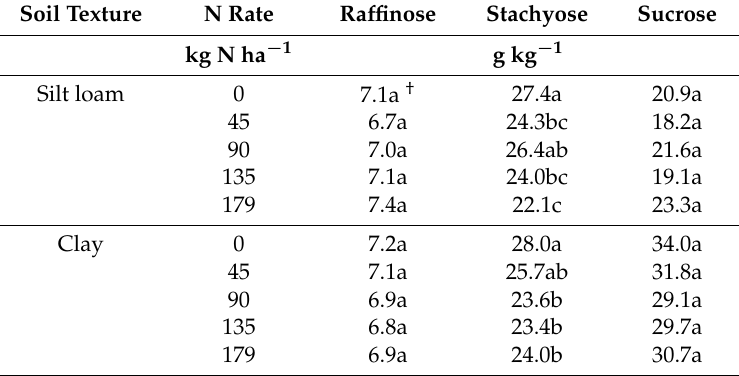
Table 3. Soybean seed sugars including raffinose, stachyose and sucrose as affected by the N application rates in 2015. Soil Texture N Rate Raffinose Stachyose